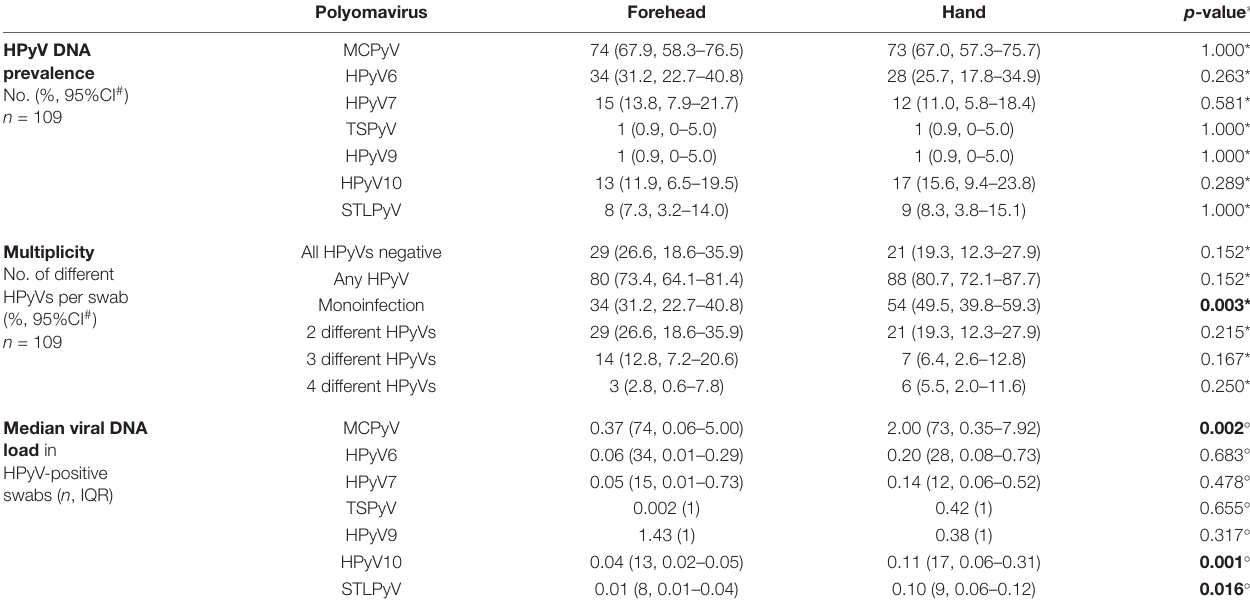
TABLE 2 | Site-specific human polyomavirus (HPyV) prevalence, multiplicity, and viral load at baseline. Polyomavirus Forehead Hand p -value ∗ , ◦ HPyV DNA prevalence